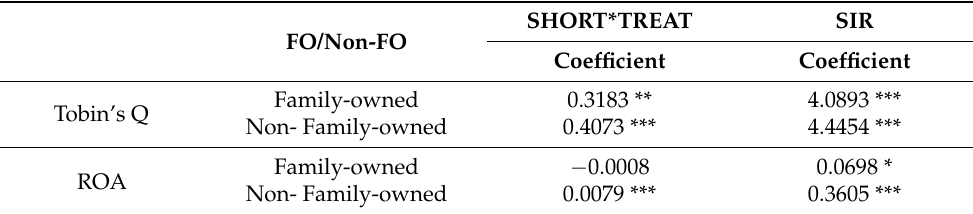
Table 8. Family ownership vs. non-family